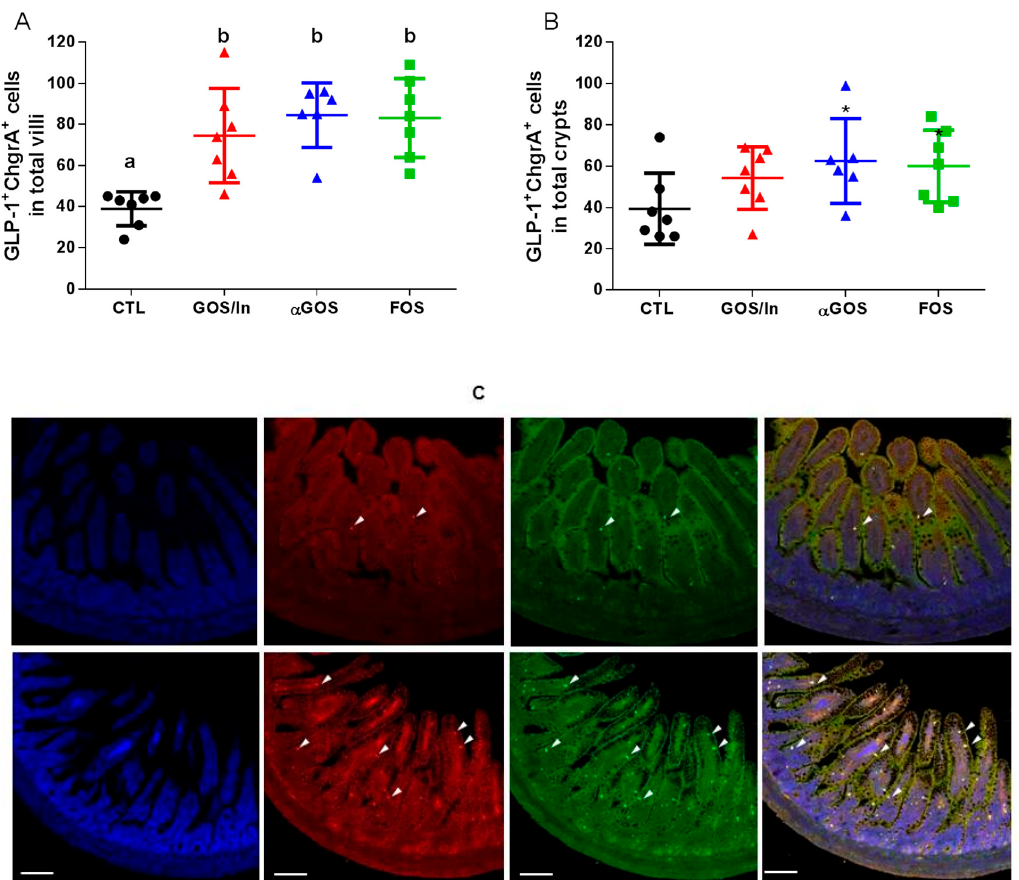
Figure 4. Effect of oligosaccharides (OS) supplementation on the density of GLP-1 cells in ileum: ( A ) in villi ( B ) in crypts. Different letters indicate significant differences among groups ( p < 0.05); Individual, mean and SD values are plotted ( n = 6 to 7 per group). ( C ) Representative images of immunofluorescence in ileal sections from a control solution (CTL) (top) and α GOS groups (down), arrows indicate positive fluorescence in cells: blue (DAPI, nuclei staining), red (GLP-1 cells), green (ChrgA cells) and merge (GLP-1/ChrgrA cells). Bars indicate 100 μ m. In agreement with this rise in the number of mature enteroendocrine cell (EEC), plasma concentrations of GLP-1 (Figure 5A) and PYY (Figure 5B) were significantly increased by all the neonatal OS supplementations, as compared with CTL.